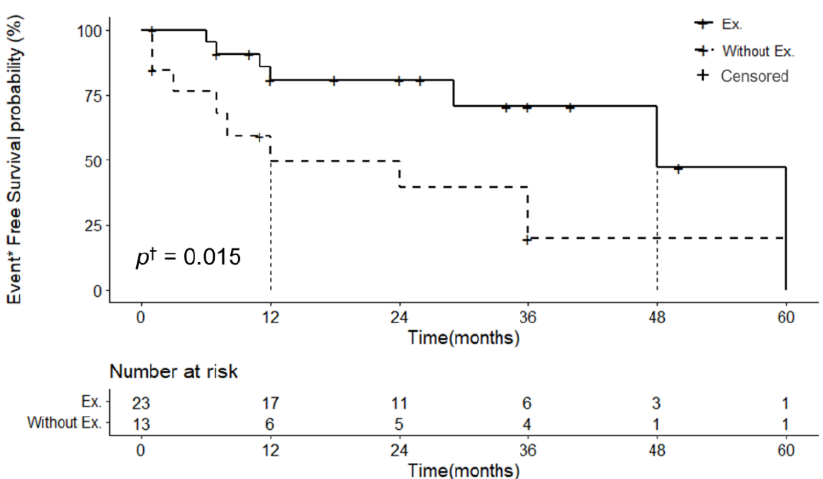
Figure 4. Comparison of event-free survival in patients who underwent and did not undergo surgi- cal excision. Ex. = Surgical excision, * Event includes recurrence and death, † Log-rank test was used for comparison the survival distributions of two